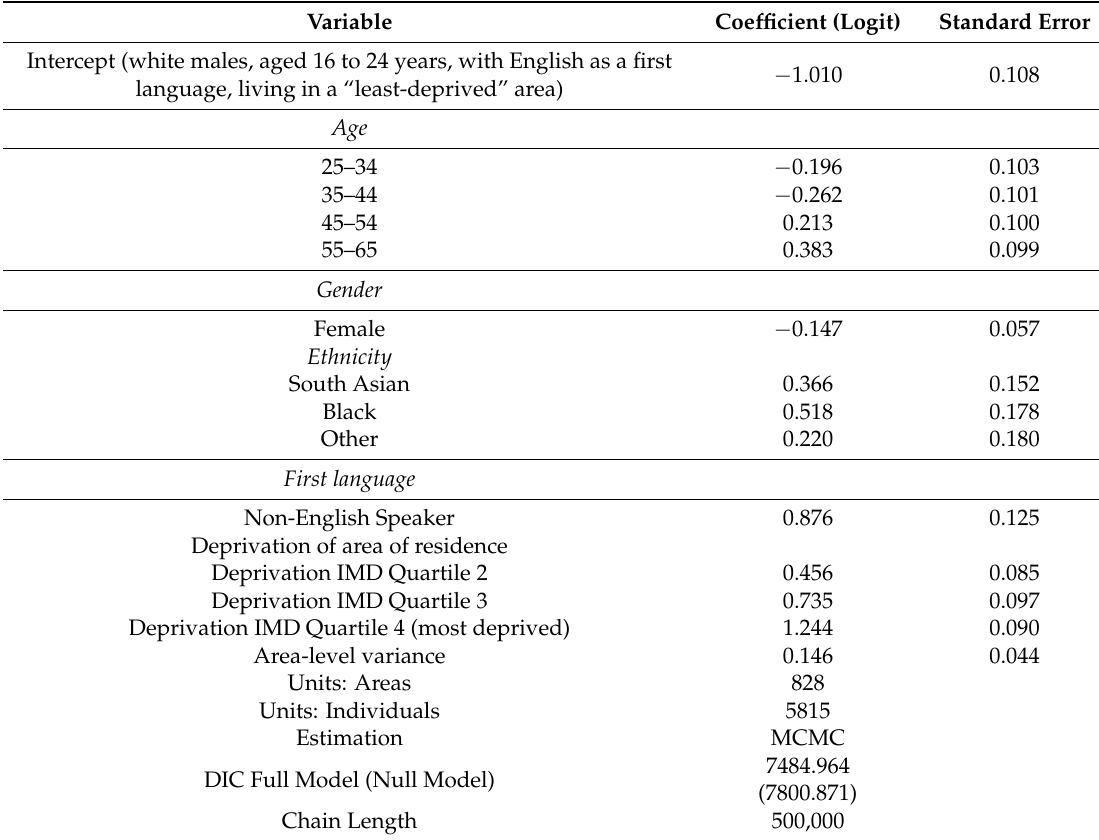
Table 1. Coefficient and fit statistics of predictive model. Variable Coefficient (Logit) Standard